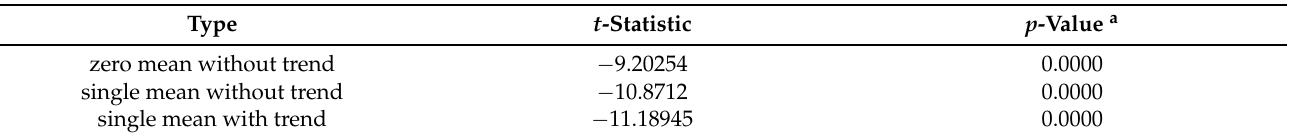
Table 4. The Augmented Dickey-Fuller Unit Root Tests for